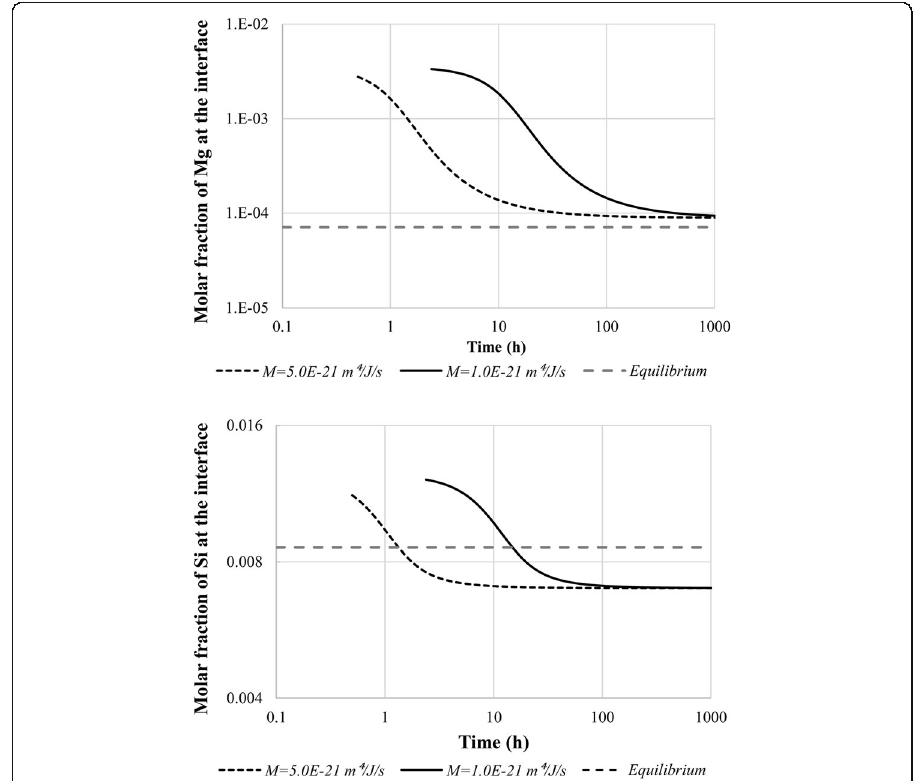
Fig. 4 Evolution of the solute molar fractions, as a function of time, at the interface of a needle-shape β ″ precipitate growing in an aluminium matrix as calculated by the mixed-mode